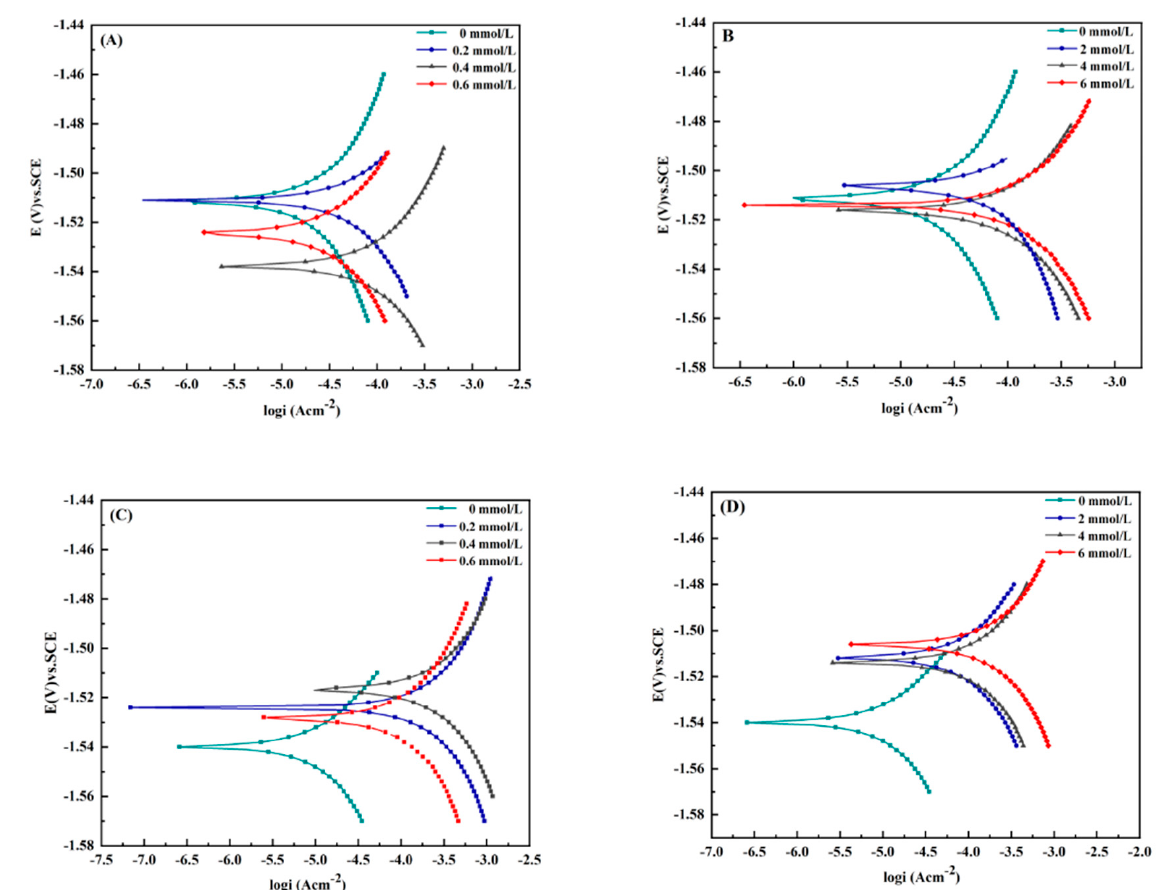
Figure 5. Potentiodynamic polarisation curves of magnesium alloys soaked in 3.5% NaCl solution with different concentrations of inorganic metabolites for 14 d. ( A , B ): magnesium alloy AZ31B in phosphate and sulphur ion solution; ( C , D ): AZ63B magnesium alloy in solution with phosphate and sulphur ions.